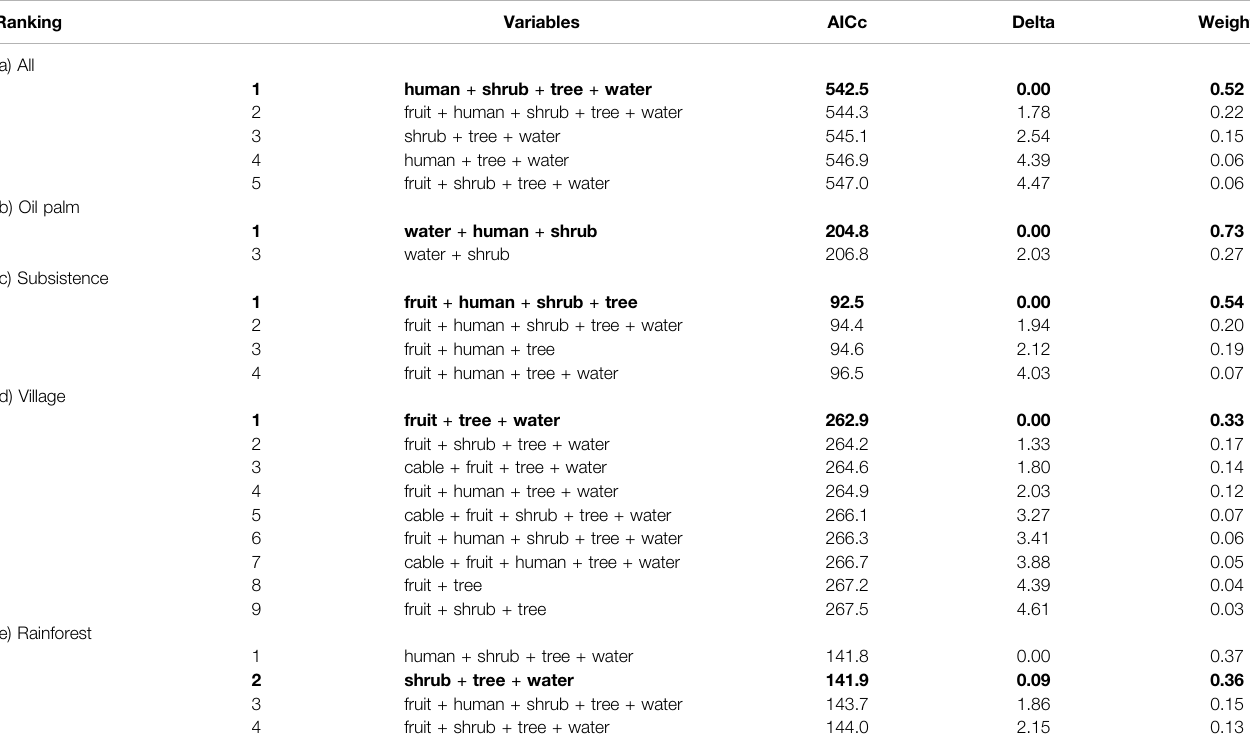
TABLE 2 | Rankingofthebeststatisticalmodelswhichwereretainedineachcon fi denceset,wheretheAkaike'sdifference(Delta) withthetop-rankedmodelwaslessthan5.0, following the Information Theoretic approach, for (a) all habitats and taxa combined, (b) oil palm, (c) subsistence agriculture, (d) village, and (e) rainforest habitats. The most parsimoniousmodelsareinbold.Weightreferstothecumulativeweightofthemodelsstartingfromthetoprankedmodel.Boldvaluessigni fi es “ Themostparsimoniousmodels ” .